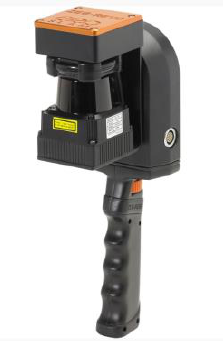
Figure 6. The ZEB-REVO personal mobile laser scanner, hand- held